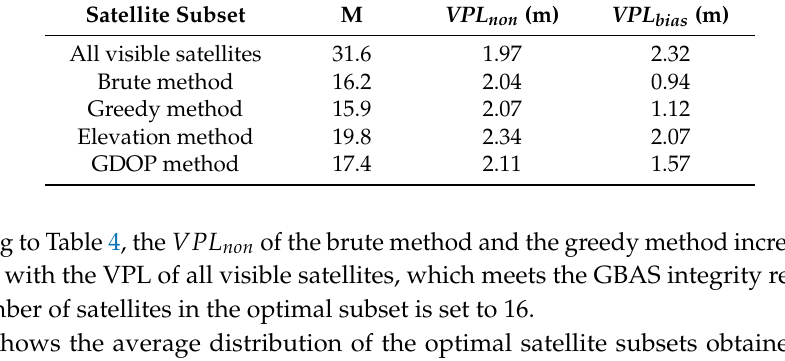
Table 4. The average satellite number M, Table 5. Average distribution of the optimal satellite subsets under the brute